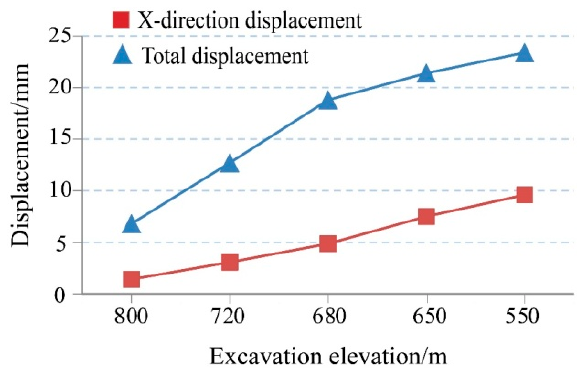
Figure 13. The variation in the horizontal displacement and total displacement at the monitoring point.